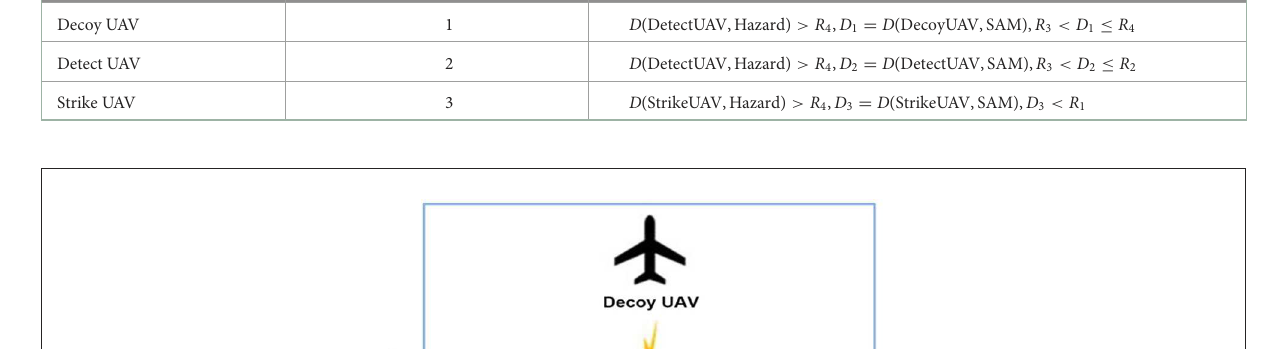
FIGURE3 Schematic of safe RL.